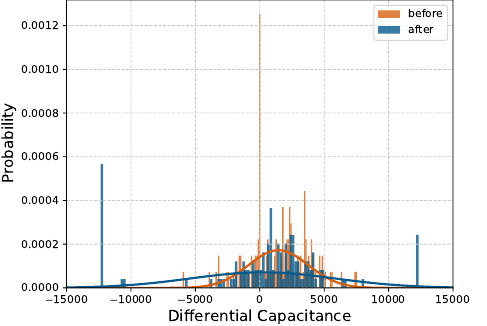
(b) Normalized distribution of the differential capacitance (with Gaussian fit) before and after the attack. Figure 7: Analysis of the effect of a drilling attack on the differential